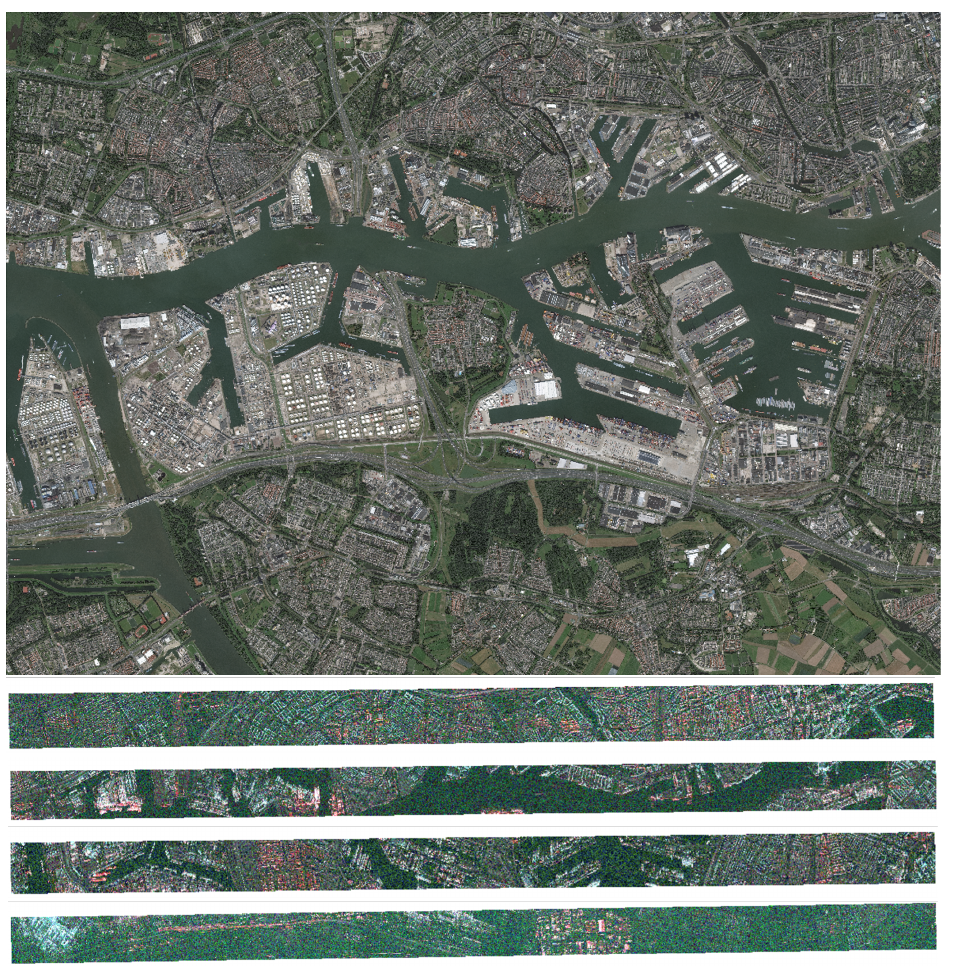
Figure 5. Sample raw images from E-SN6. The ( top ) are the optical data and the ( bottom ) four strips are SAR